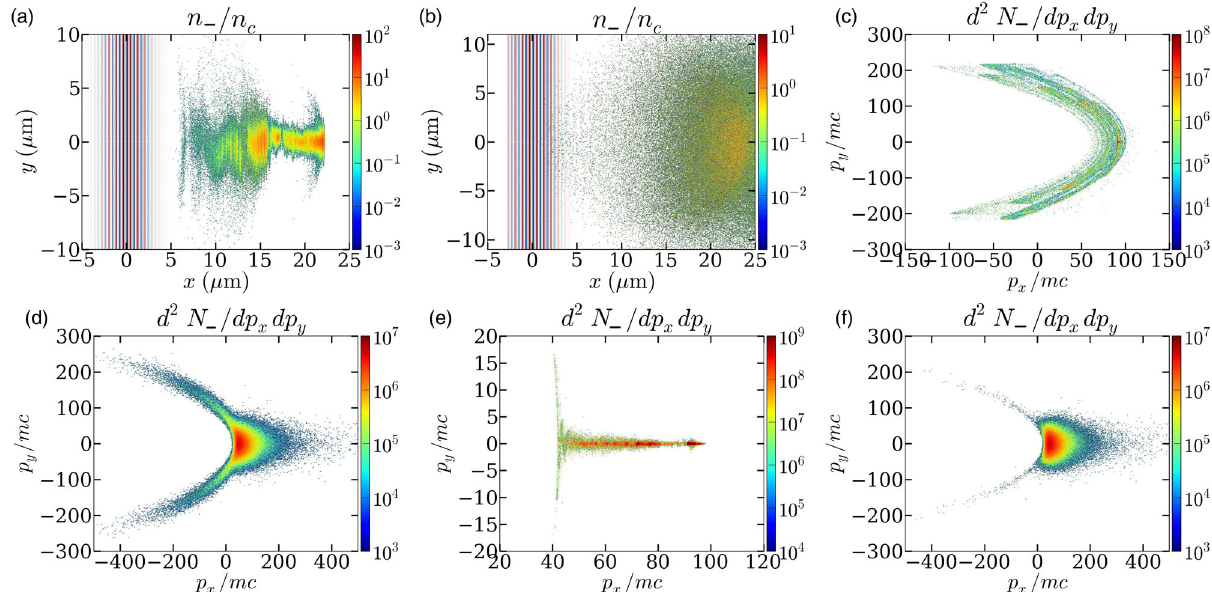
FIG. 9. Laser-induced scattering of the beam electrons as predicted using classical radiation reaction (left column) or quantum synchrotron emission (right column). (a,b) Density distribution in the x − y plane of the incoming beam electrons following the laser interaction. (c,d) Momentum distribution in the p x − p y plane of the incoming beam electrons during the laser interaction at the time of maximum angular divergence. (e,f) Momentum distribution in the p x − p y plane of the incoming beam electrons following the laser interaction. Note that the x -axis and the color map scales are changed in each